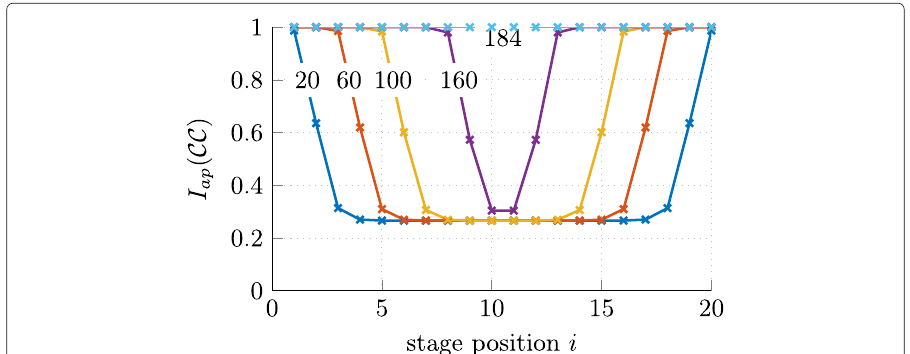
/ N = − 2.58 dB. Here, L = s 0